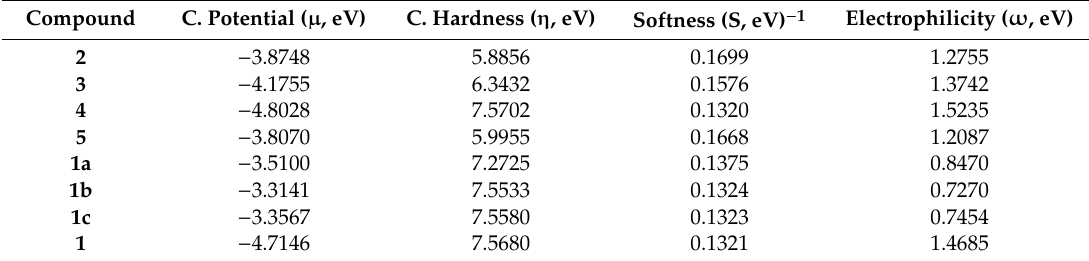
Table 7. Global reactivity descriptors for the compounds